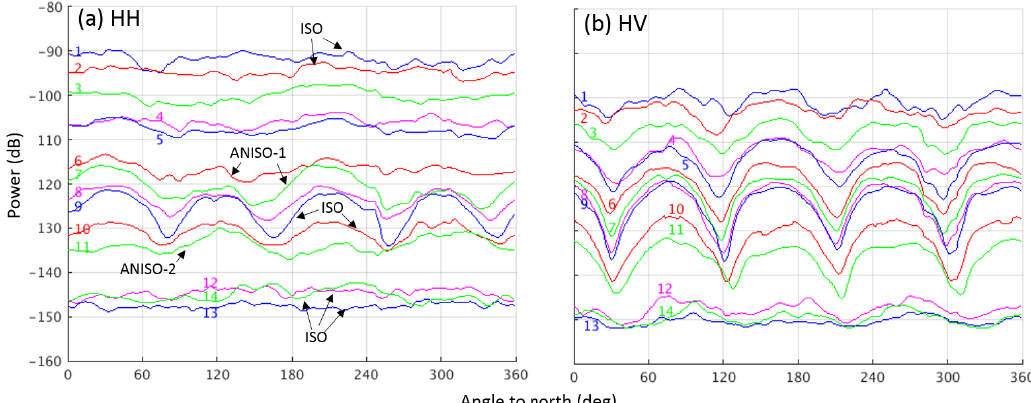
Figure 5. Power profiles with respect to the angle of north at different depths for HH and HV measurements. Four colors (blue, red, green, and magenta) are cycled through for distinguishing close profiles and all the profiles are numbered from 1 to 14 in increasing order, according to their respective depths from the top to the bottom. The annotations in panel (a) illustrate the isotropic and anisotropic patterns discussed with Fig. 7 at the end of Sect.